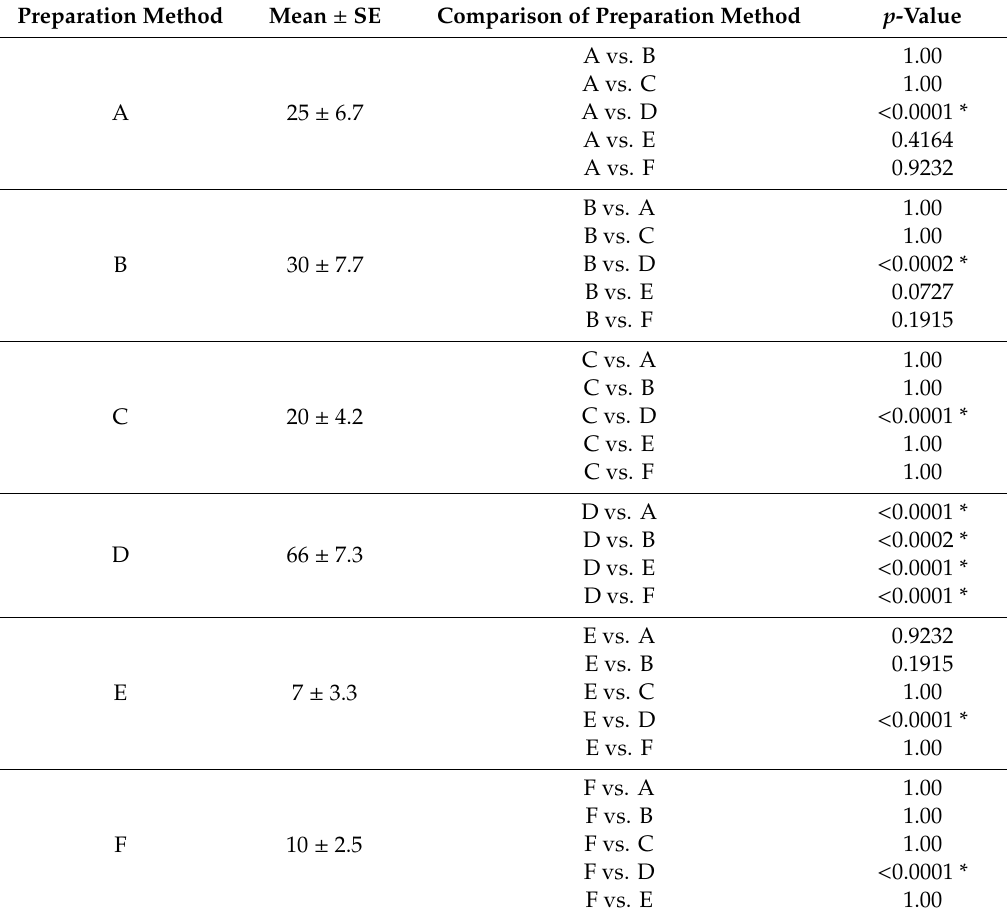
Table 3. Mean values, standard errors (SEs), and Bonferroni multiple comparison tests for means of percentage of dye penetration between preparation